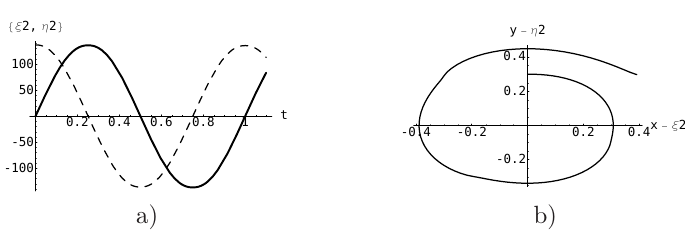
Figure 4. 2 -type solution ( ξ 2 ( t ) ,η 2 ( t )) of the problem (5.1): a) initial data ξ 2 (0) = 0 , η 2 (0) = 137 . 0835 ; b) phase portrait of the difference between neighboring solution ( x ( t ; δ ) , y ( t ; δ )) and ( ξ 2 ( t ) , η 2 ( t )) , t ∈ [0 , 1] , if δ = 0 . 3 .